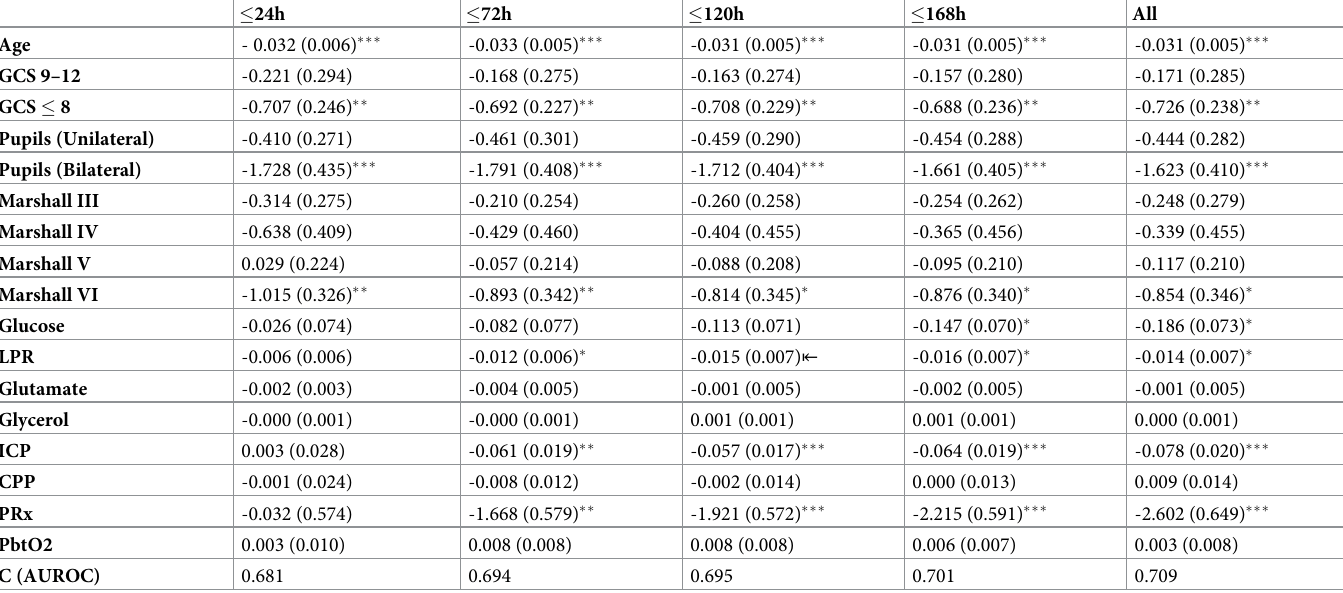
Table 2. Proportional odds regression against Glasgow Outcome Score (GOS) of baseline characteristics, microdialysis analytes, and monitoring parameters aver- aged over different intervals following